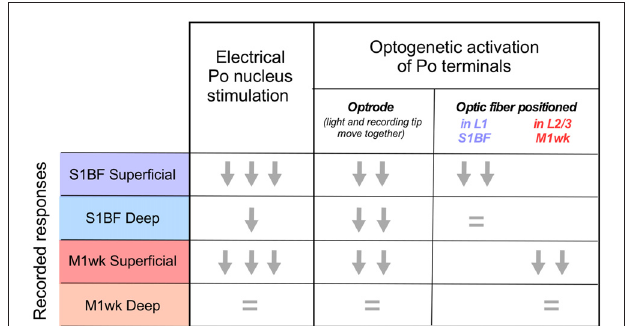
FIGURE 8 | Posterior nucleus thalamocortical cell activation effects on responses to passive multi-whisker stimulation in M1wk and S1BF cortices. Graphic summary of the effects observed in the superficial and deep layers of each area in the different experimental conditions. Response magnitude is represented as one, two or three arrows. An “equal” symbol indicates no